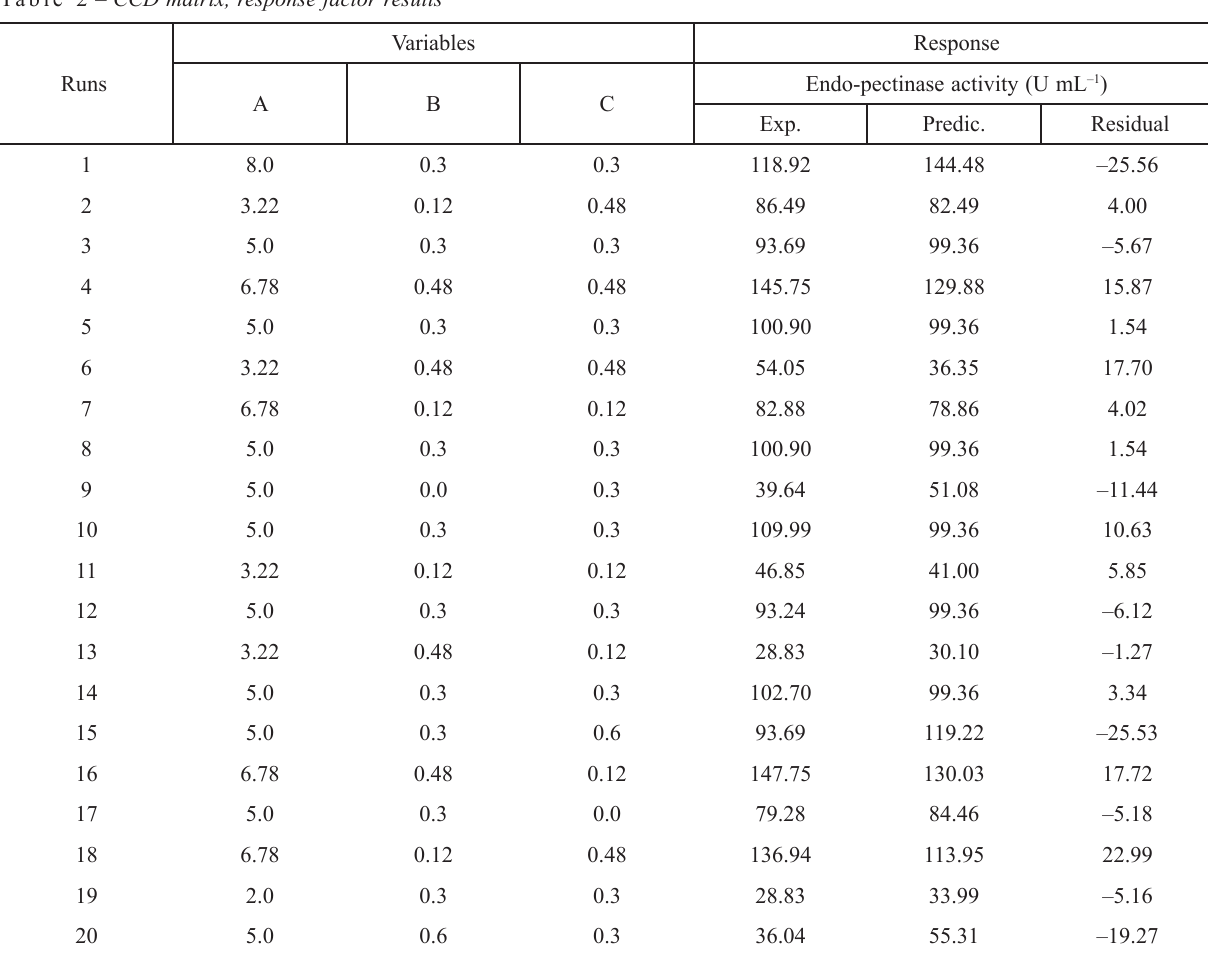
Table 2 – CCD matrix, response factor results